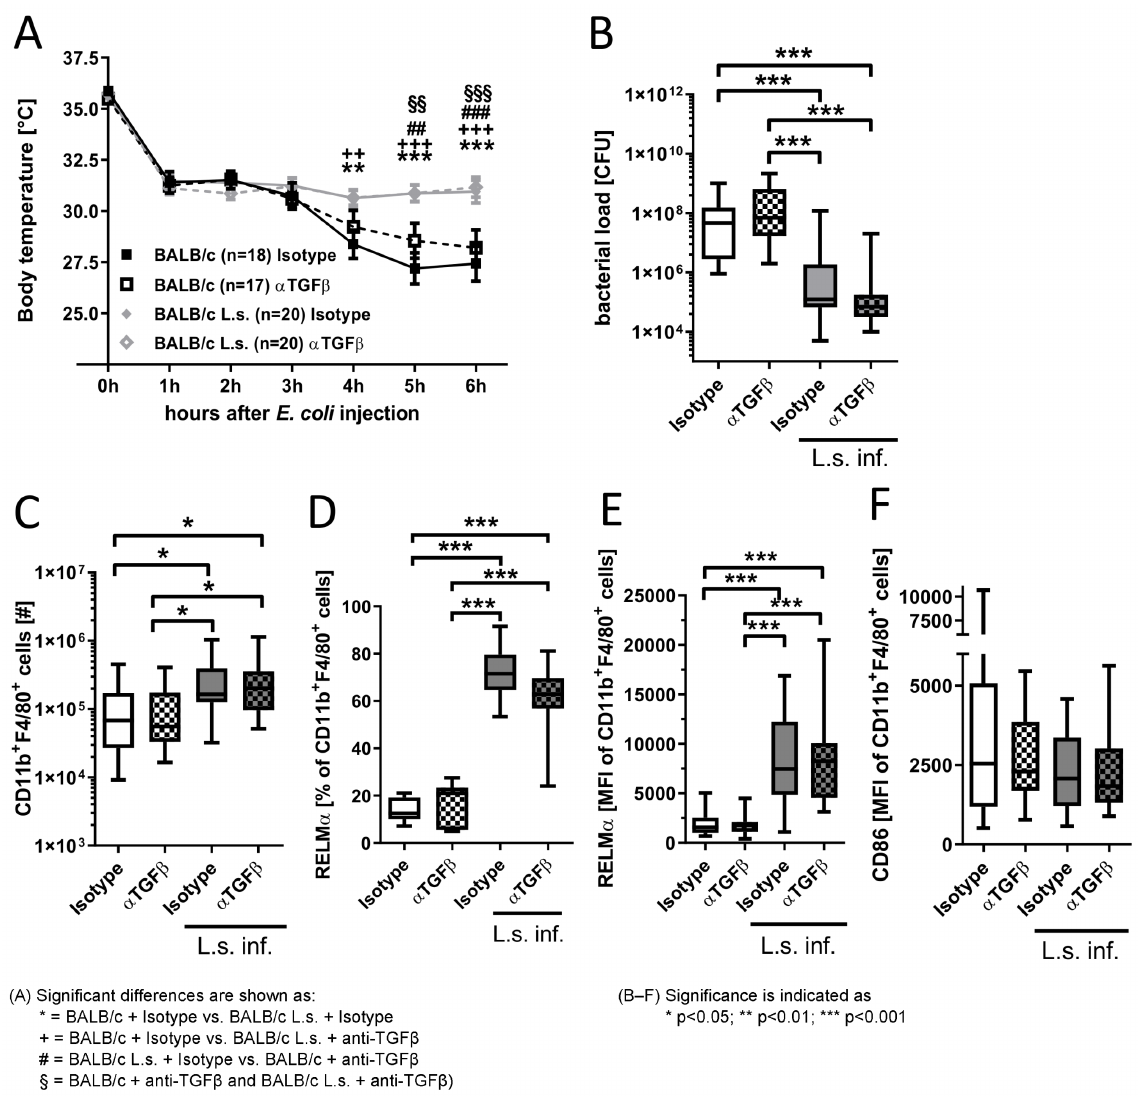
Figure 2: TGFβ depletion does neither alterE.coli-induced hypothermia, peritoneal bacterial burden, nor impair the filaria-mediated protective